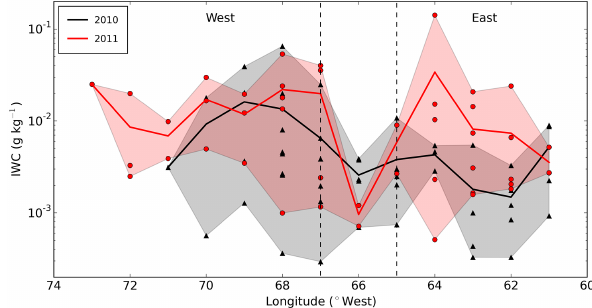
Figure 9. Same as Fig. 4, for the ice water content (IWC, gkg − 1 ).